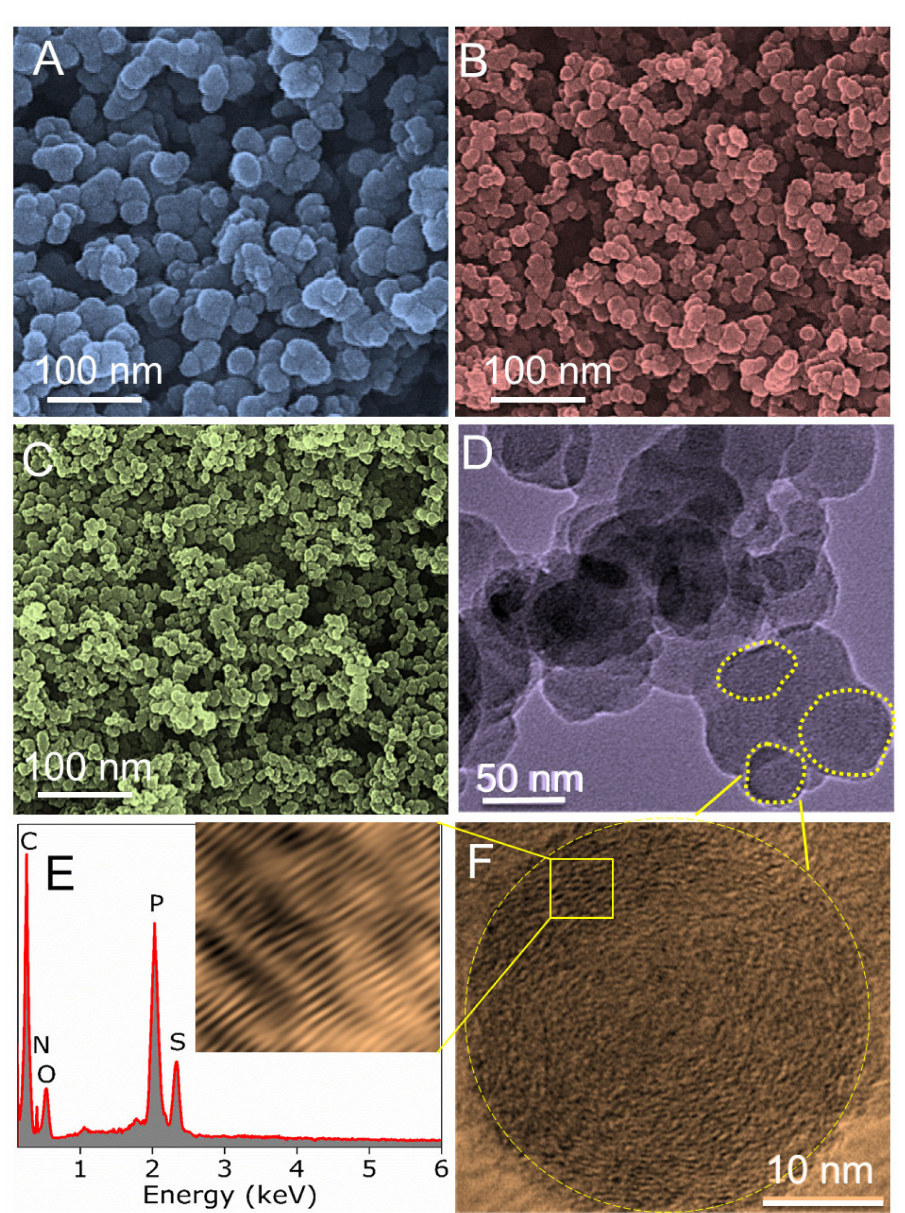
Figure 2. SEM and TEM images revealing homogeneity in SNPO-CPL nanoparticles. SEM images of ( A ) SNPO-CPL-600 ( B ) SNPO-CPL-800 and ( C ) SNPO-CPL-1000. ( D ) TEM images of SNPO-CPL-800 ( E ) EDS line spectrum (inset inverse-FFT) and ( F ) HRTEM of the